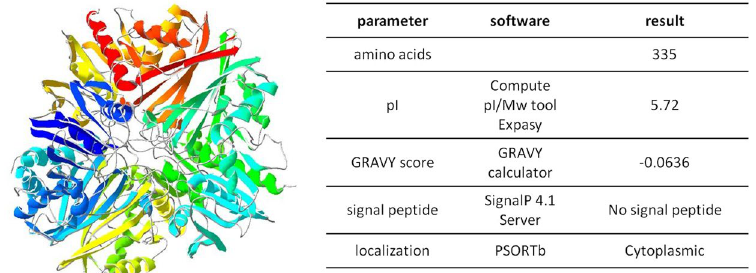
Figure 2. Model of GAPDH and sequence characteristics. Model was prepared based on sequence with 74.55% identity which was Streptococcus agalactiae GBS GAPDH (template: 5jyf.1.A).